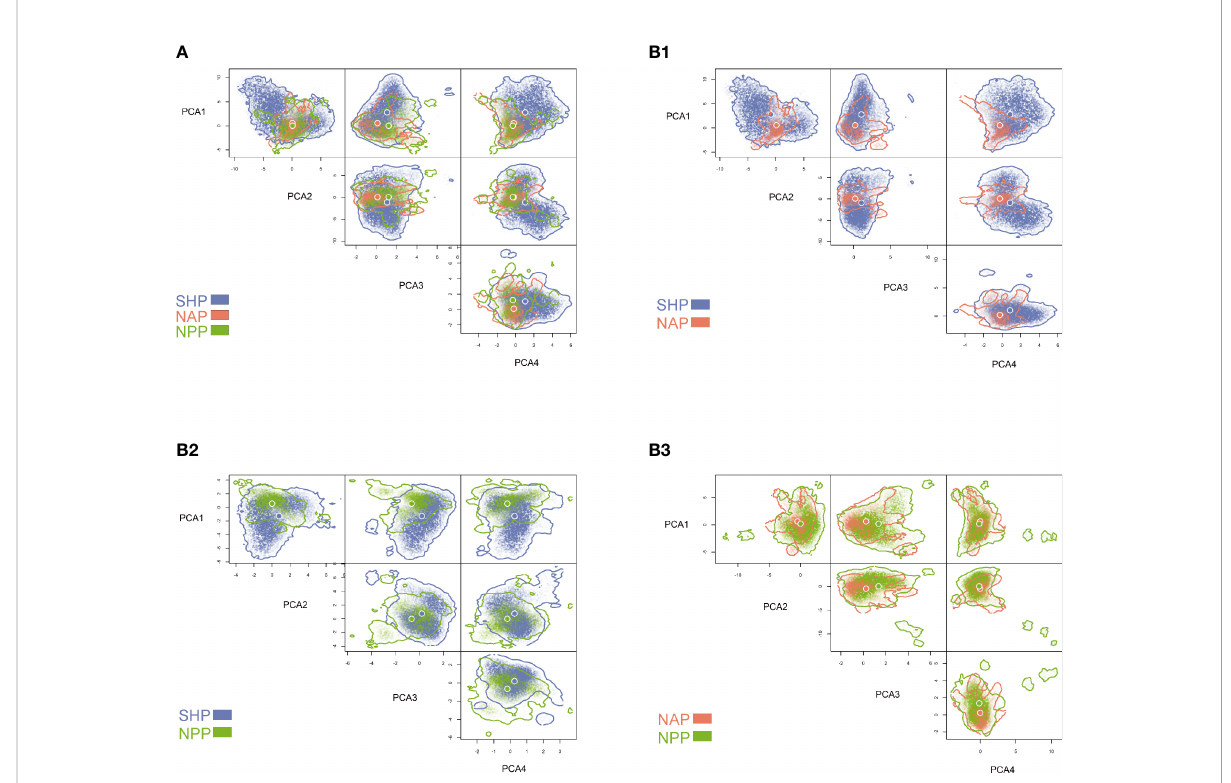
FIGURE 2 The four-dimensional hypervolumes for the Southern Hemisphere population (SHP), North Atlantic population (NAP) and North Paci fi c population (NPP). The overlapping hypervolumes for the three populations (A) , SHP and NAP (B1) , SHP and NPP (B2) and NAP and NPP (B3)